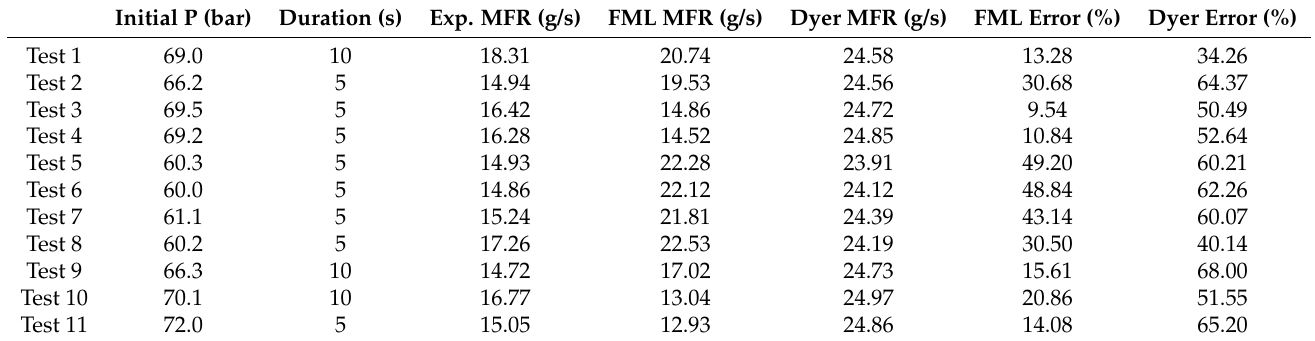
Table 2. Comparison between the average experimental mass flow rate and the one predicted by the FML and Dyer’s model for the first experimental setup.